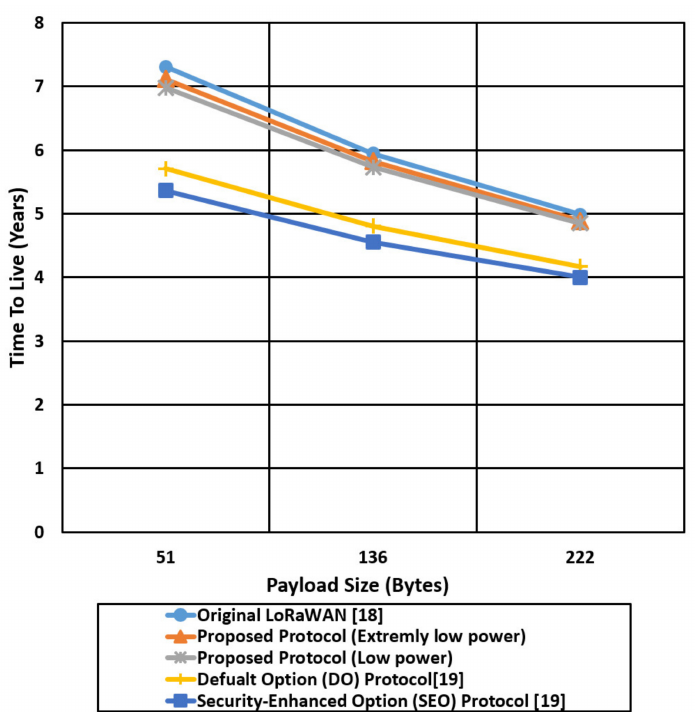
Figure 20. Comparison of the battery lifetime in terms of years for the proposed protocol cases and the other mentioned protocols using the best-case environment parameters (SF